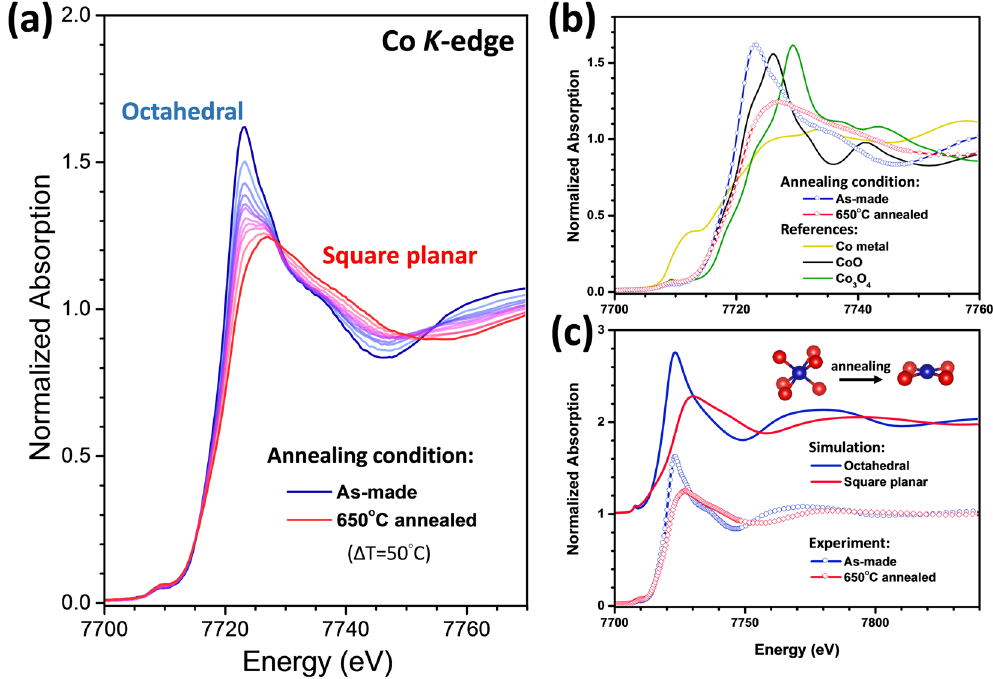
Figure 3. ( a ) Co XANES data for Co-doped CeO 2 sample annealed at different temperatures. ( b ) Comparison of XANES of as-made and 650 °C-annealed samples with spectra from reference compounds. ( c ) FDMNES simulated Co XANES spectra.